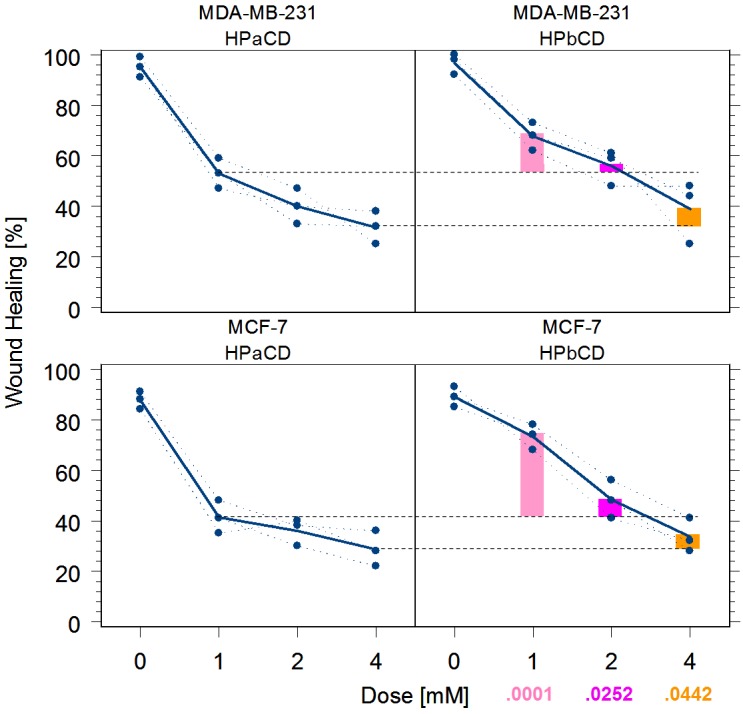
Wound healing by cyclodextrins in breast cancer cell lines.Cells were grown in triplicates for 12h and incubated with either of the CDs for 2h at the concentration indicated (0–4mM), before a 0.9mm wide gap was opened and cells were allowed to migrate into the “wound” for 12h. HPβCD is more than 10× as toxic as HPαCD, which at <100mM does not affect epithelial cell viability.[75, 76] Dashed horizontal line indicates inhibition of wound healing in HPαCD at 1 and 4 mM respectively. ANOVA results: indep: HPαCD vs HPβCD (fixed) block: MCF-7/MDA-MB-231 (fixed) dep: %change in wound healing 1mM α vs 1mM β, p = .0001 ***1mM α vs 2mM β, p = .0252 *4mM α vs 4mM β, p = .0442 *.